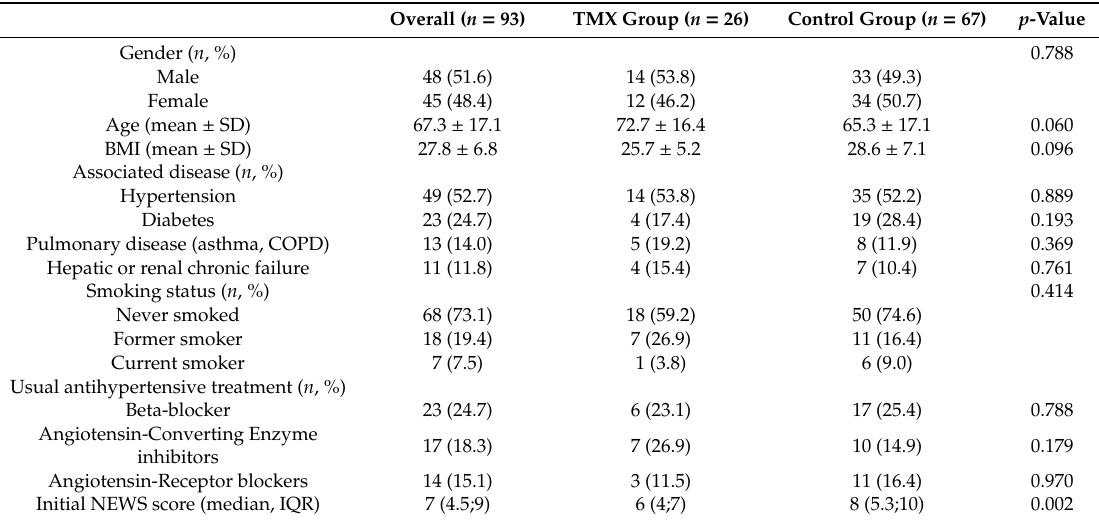
Table 1. Characteristics of the 93 patients at